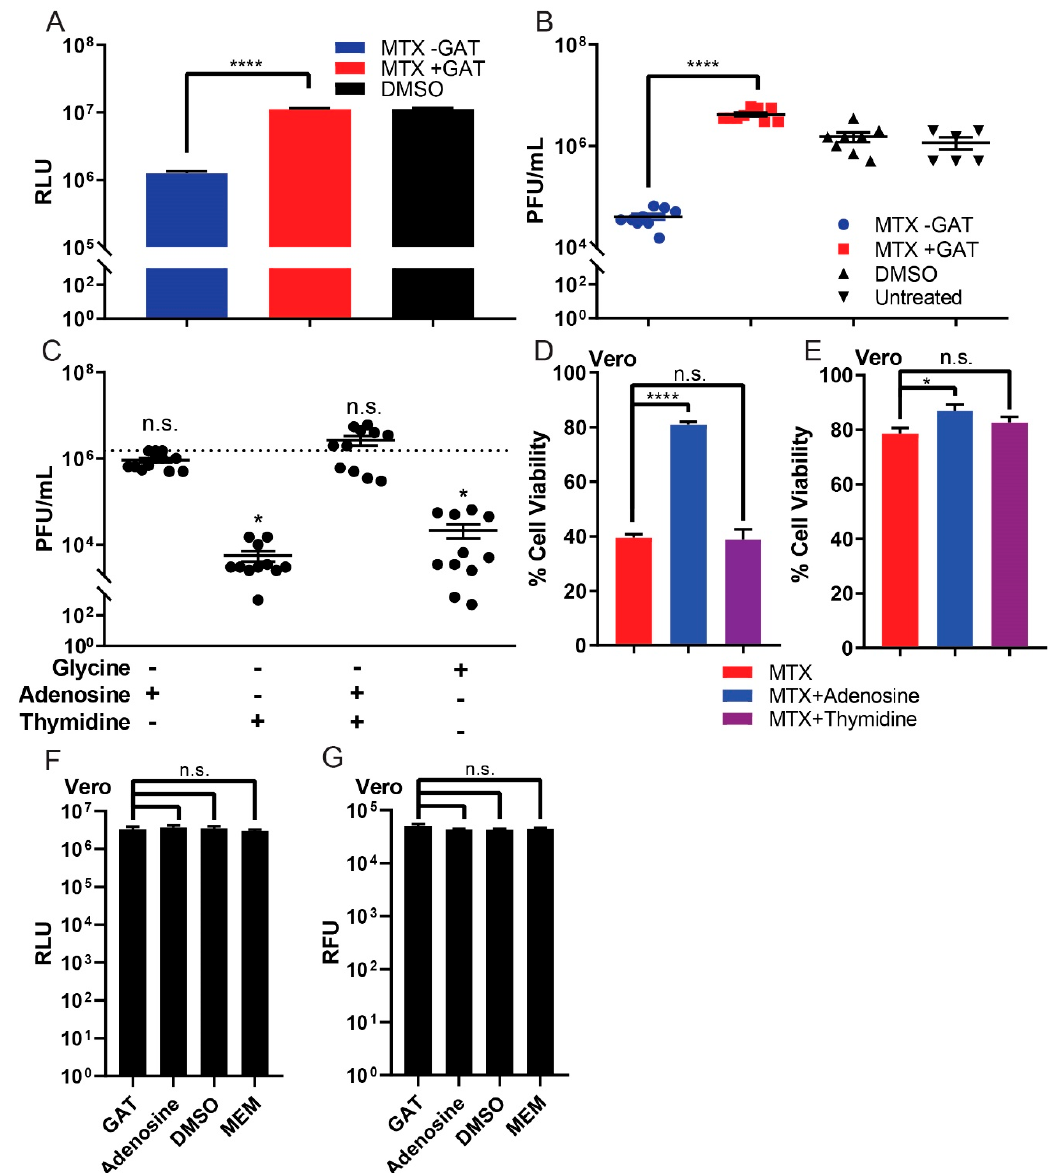
Figure 4. Rescue effect of GAT medium on cell viability and ZIKV replication during MTX